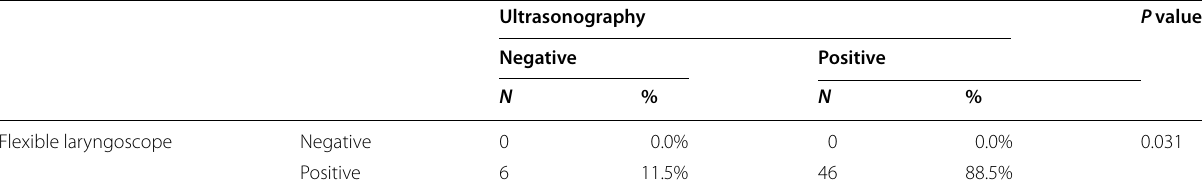
Table 3 The paired comparison between findings of flexible laryngoscopy and laryngeal ultrasound